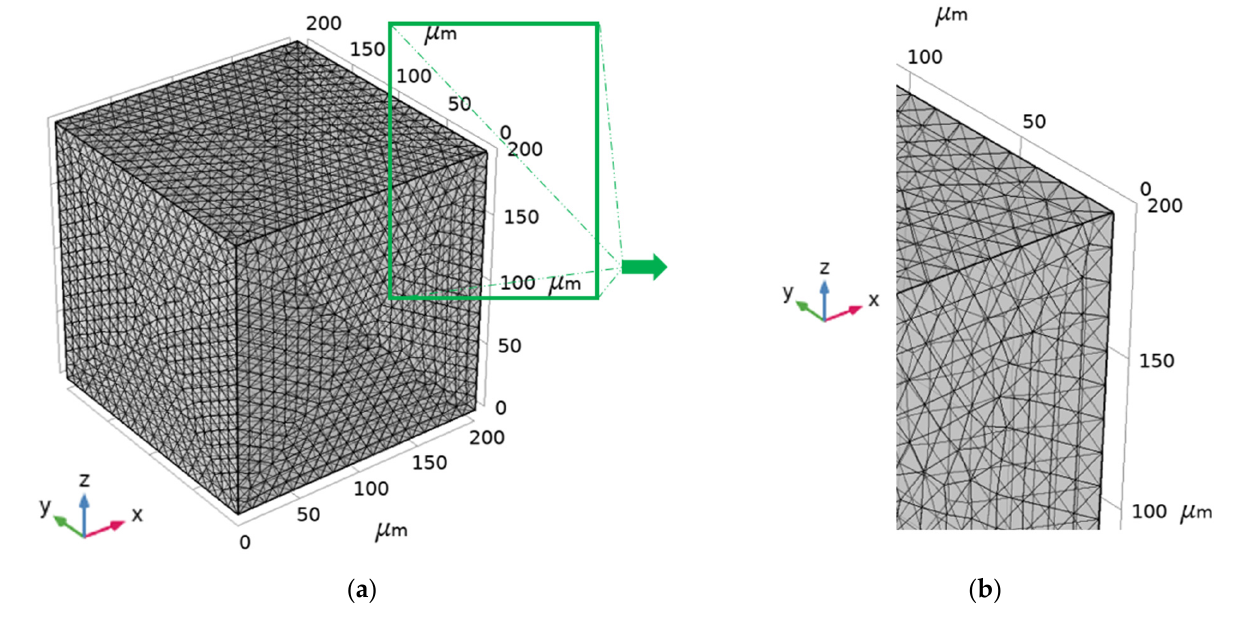
Figure 5. Mesh of simulated FEM model: ( a ) Whole; ( b )